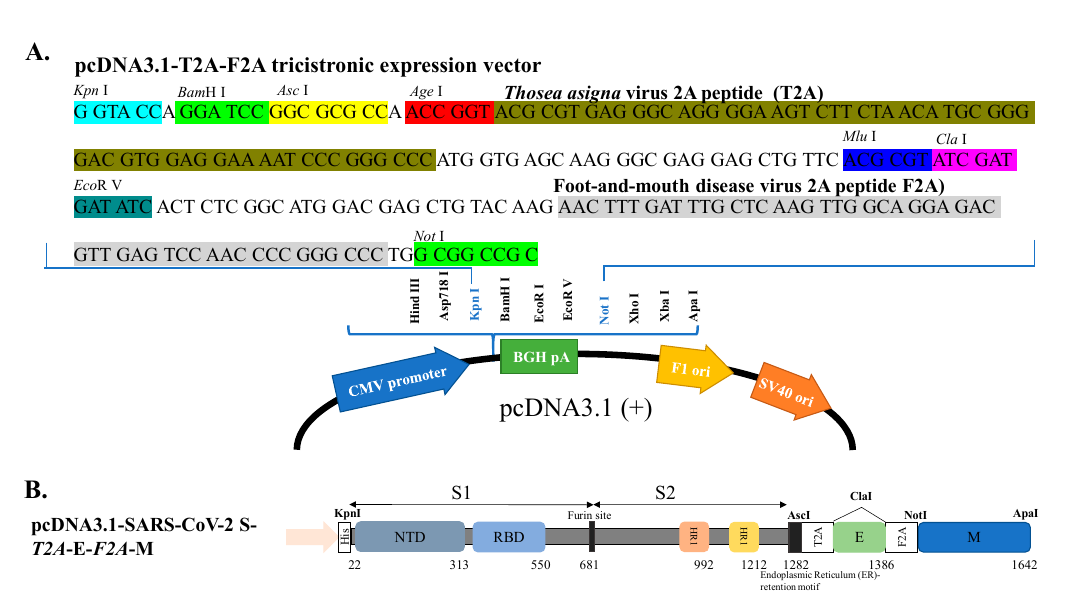
Figure 1. The construction of SARS-CoV2 S-E-M tri-expressing plasmid. ( A ) The sequence of pcDNA3.1-T2A-F2A tri-cistronic vector depicting the linker [BamHI-AscI-AgaI-T2A-MluI-ClaI- EcoRV-F2A] was inserted into KpnI/NotI sites to form a tri-cistronic expression backbone containing T2A and F2A self-cleaving peptides. ( B ) The construction of pcDNA3.1-SARS-CoV-2 S-T2A-E-F2A-M depicted that the cDNA of spike inserted into KpnI/ AscI sites, E inserted into ClaI and M inserted into NotI/ApaI sites.